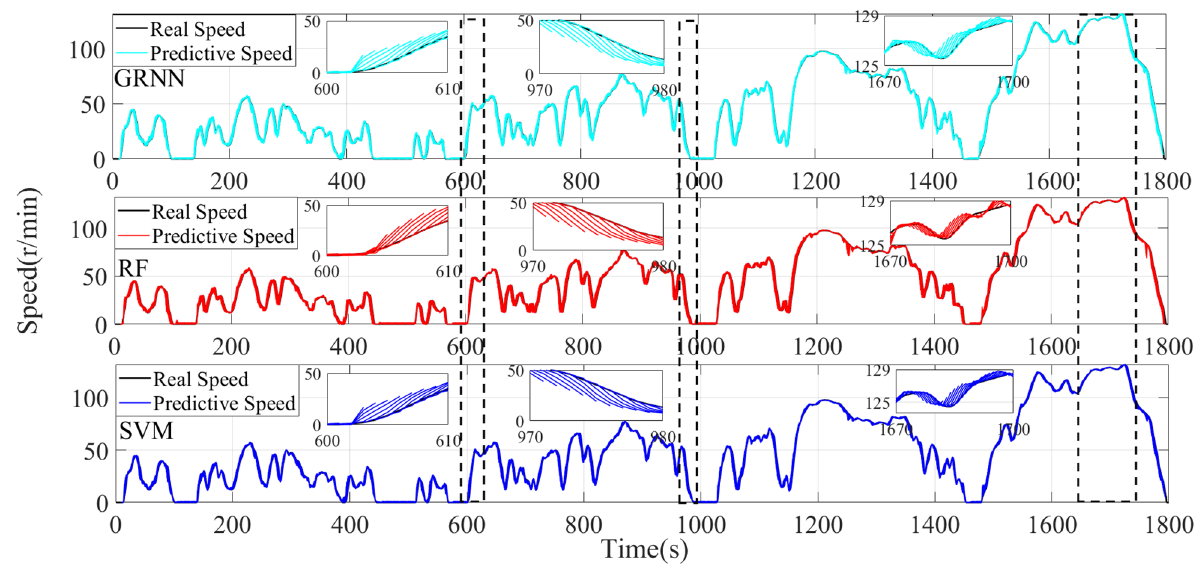
Figure 7. Variation curves of the predictive speed based on GRNN, RF, and SVM. Table 4. The error comparison table based on RF, SVM, and GRNN.